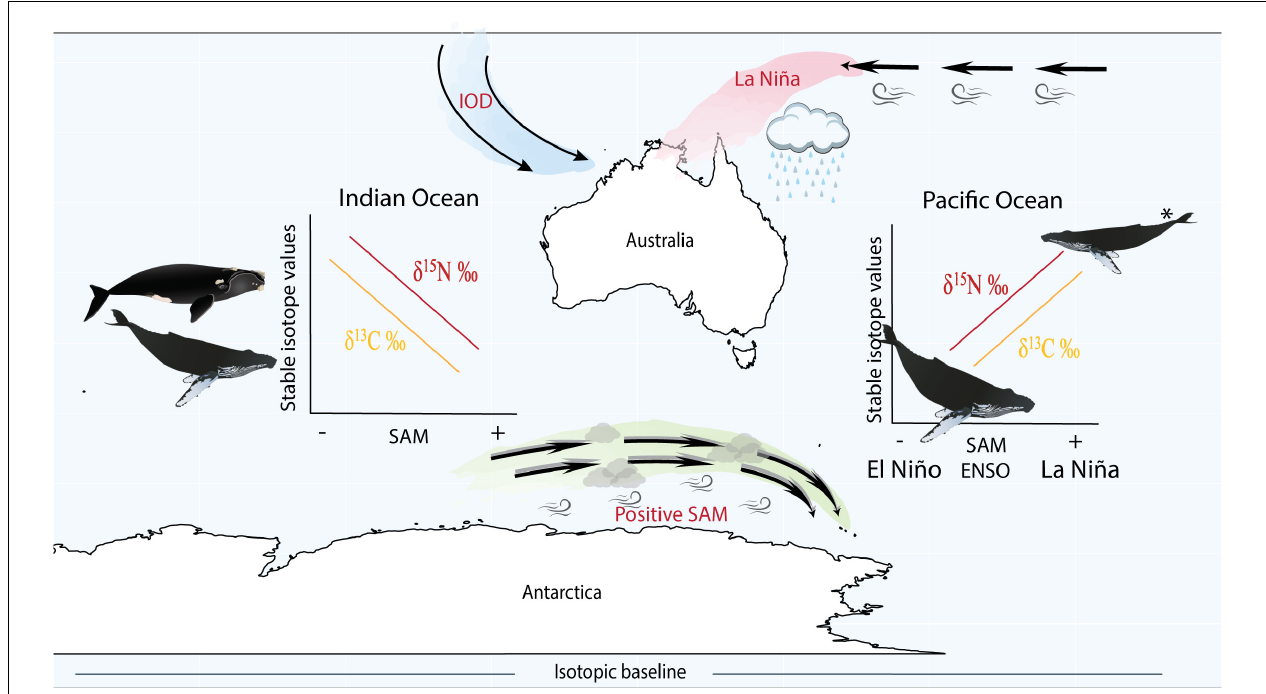
FIGURE 4 | Schematic figure illustrating the main findings from the study and the positioning of climate cycles. La Niña (a phase of ENSO) corresponds to warmer and increased wet conditions in the west Pacific Ocean, while positive SAM (known to correspond to La Niña phases of ENSO) also drives an increase in storm conditions, however, has a stronger influence over the Southern Ocean. IOD is more prominent in the Indian Ocean and positive and negative phases are more complicated and not strictly in phase with either ENSO or SAM, making it difficult to compare with these climate cycles. Within the Pacific Ocean, we found that humpback whales displayed enriched nitrogen and carbon stable isotope values during positive SAM and La Niña periods (potentially reflecting poor feeding conditions) and depleted stable isotope values during negative SAM and El Niño phases. In the Indian Ocean we found the opposite trend, where humpback and southern right whales exhibited depleted nitrogen and carbon stable isotope values during positive SAM (potentially reflecting improved feeding conditions) and enriched isotope values during negative SAM. *In the Pacific Ocean during La Niña/positive SAM, whales from the same population were found to be in a lean body condition due to reduced sea ice concentration and resource availability (Bengtson Nash et al., 2018). However, such information is unavailable for whales in the Indian Ocean. Our interpretations assume variation in isotope values reflect changes in resource availability rather than variation in baseline isotope